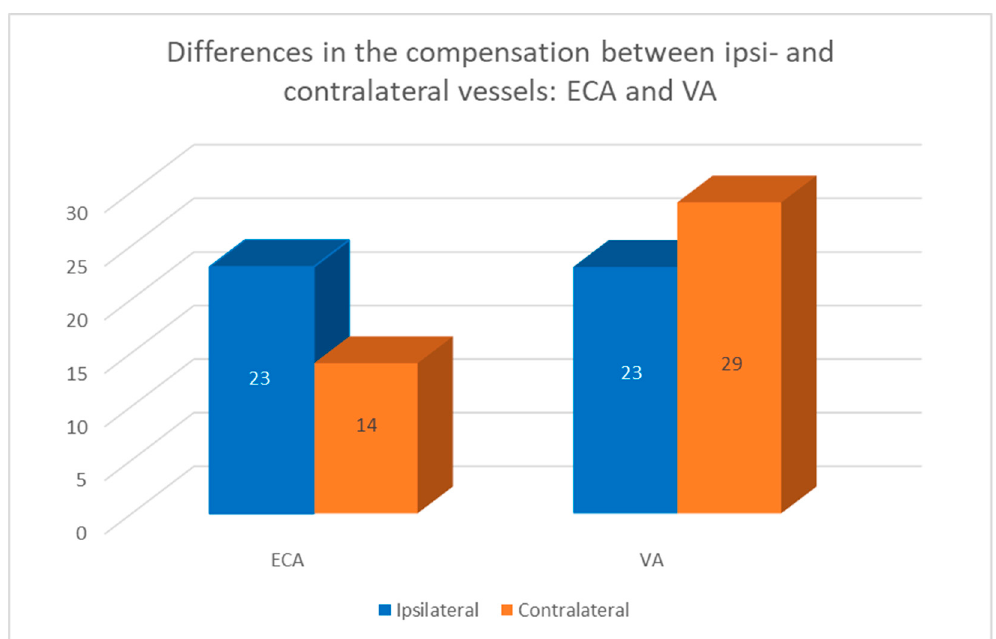
Figure 4. Differences in compensation in the ECA and VA between ipsilateral and contralateral vessels. Compensatory increased flow was more frequently observed in ipsilateral ECA (23 vs. 14) and in contralateral VAs (29 vs. 17).